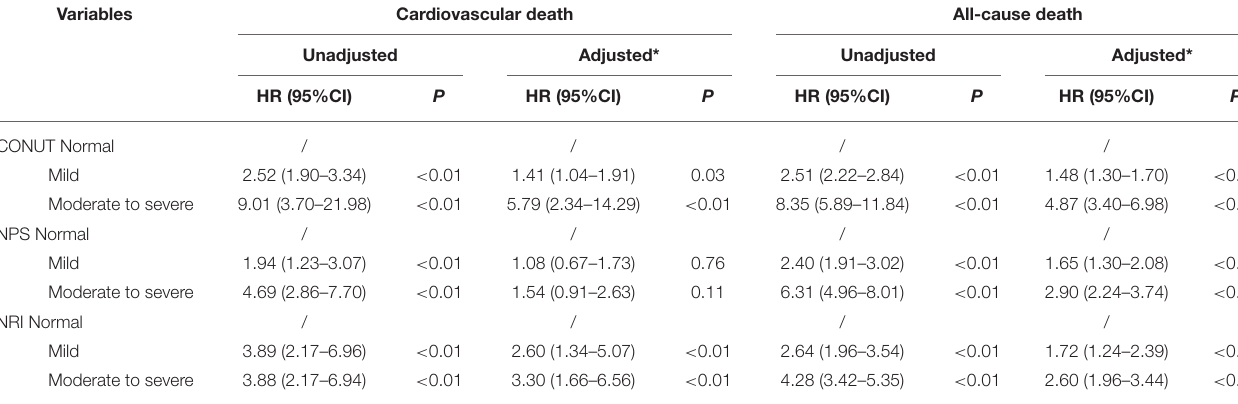
TABLE 5 | Univariate and multivariate Cox regression of three nutritional screening tools for cardiovascular death and all-cause